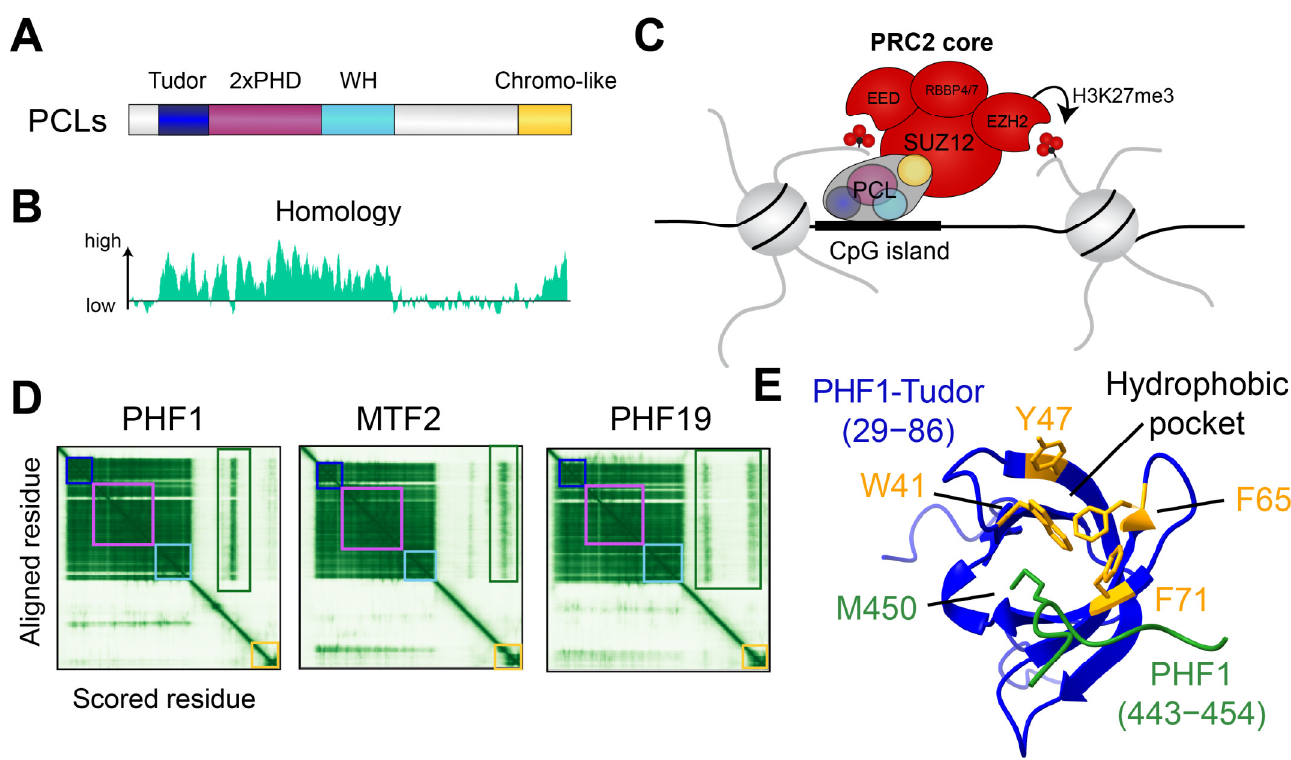
Figure 1. ( A ) General domain structure of the three PCLs. ( B ) Amino acid homology between the three human PCLs. ( C ) Model of the functional role of the PCLs for recruiting PRC2. PCL interacts via the winged helix domain with unmethylated CpG islands and recruits PRC2 by interaction of the C-terminal chromo-like domain with the PRC2 core. The histone methyltransferase EZH2 facilitates H3K27me3 methylation. EED interacts with H3K27me3 and contributes to PRC2 recruitment, as well. ( D ) Predicted aligned error of human PHF1, MTF2, and PHF19 obtained from the AlphaFold database [31]. Green rectangles indicate predicted associations of the unstructured regions with the chromatin-binding internal domains. ( E ) AlphaFold2 predicted the association of the amino acids 443–454 with the Tudor domain of PHF1. Amino acids forming the hydrophobic pocket are marked yellow. Structure obtained from the AlphaFold database of human PHF1 (O43189, version 2022-11-01) [31].